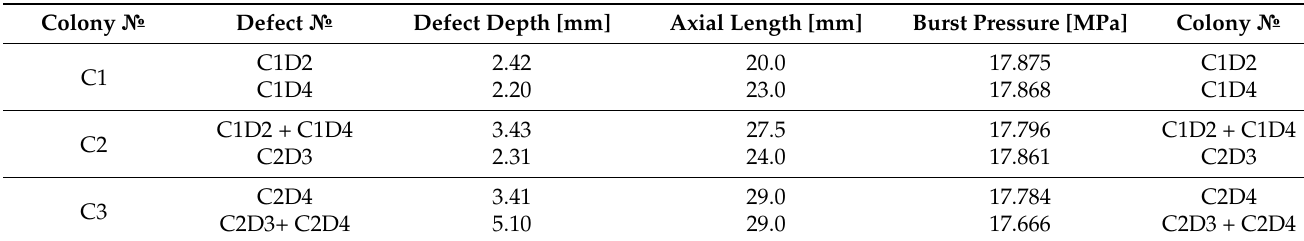
Table 4. The results of the pipe wall plastic collapse calculated according to DNV-RP-F101 standard. Source: Author’s